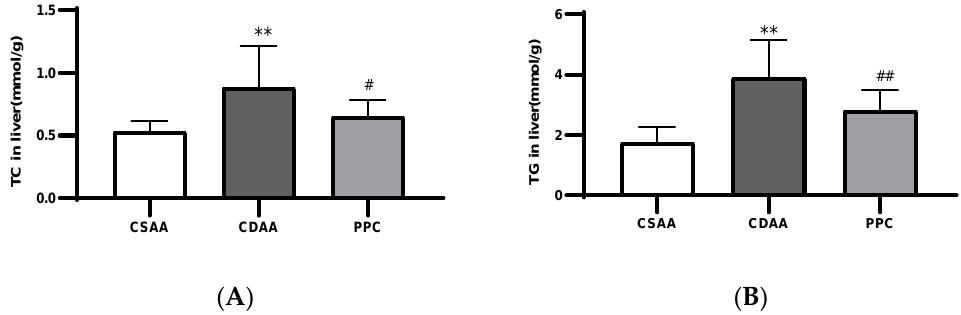
Figure 3. TC ( A ) and TG ( B ) levels in the mouse liver tissues at week 12. ** p < 0.01 compared with the negative control (CSAA diet) group; # p < 0.05, ## p < 0.01 compared with the model (CDAA diet) group.